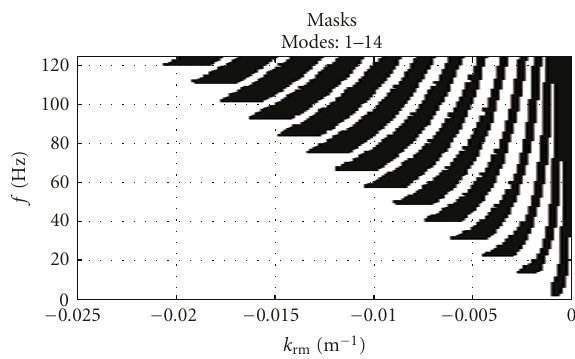
Figure 8: Set of binary masks in the f - k domain built from dispersion curves given in Figure 6 by bi-dimensional dilatation process. The set is complete for the studied environment.